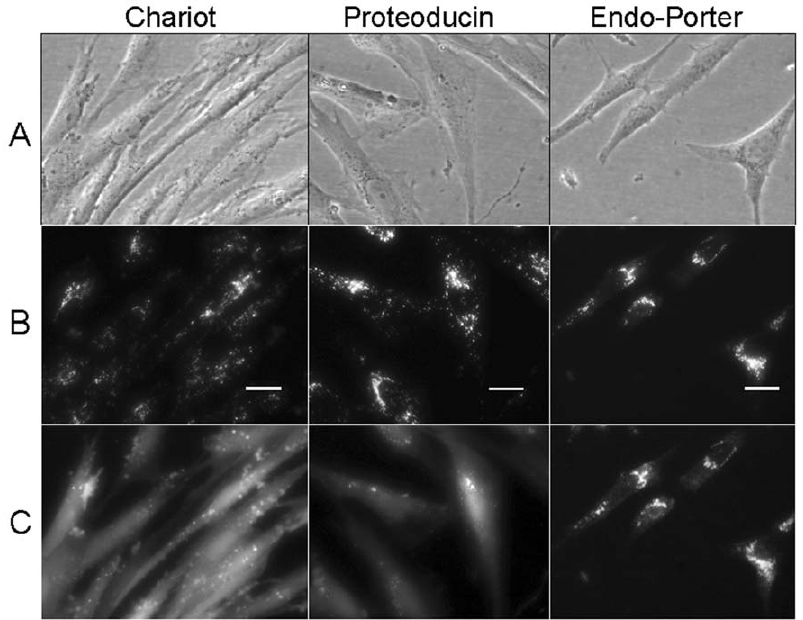
Figure 3. Effects of PCI of transduced Atto488-BSA in sarcoma cells. (A) Phase contrast picture of living sarcoma cells after protein transduction using the transduction reagents Chariot, Proteoducin or Endo-Porter. (B) Fluorescence signals inside of the same sarcoma cells. The signals are predominantly punctate with a perinuclear localisation. Only in Endo-Porter transduced cells a cytosolic signal is visible. (C) Fluorescence signals of the same cells after 200 seconds blue light exposure. The Atto488 signal has spread throughout the cytosol. In cells transduced via Chariot and Proteoducin, a clear fluorescence distribution change is visible. The existing cytosolic signal in Endo-Porter transduced cells is increased although the effect is weaker compared to the other reagents.